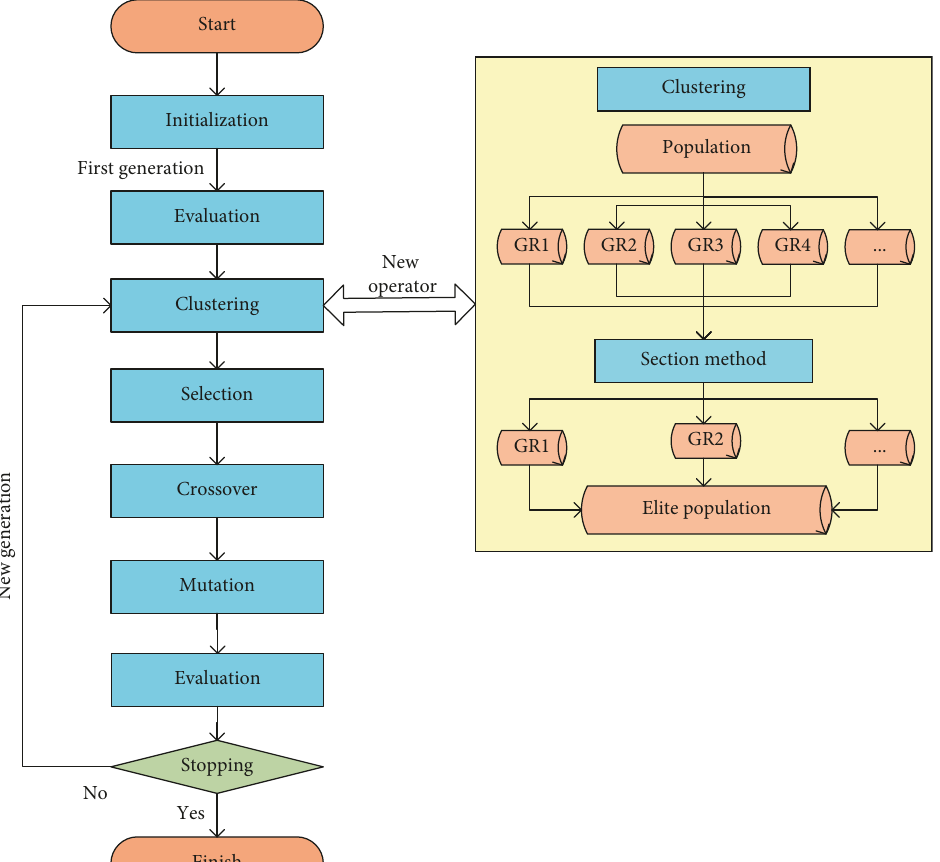
Figure 3: Multi-solution genetic algorithm flow